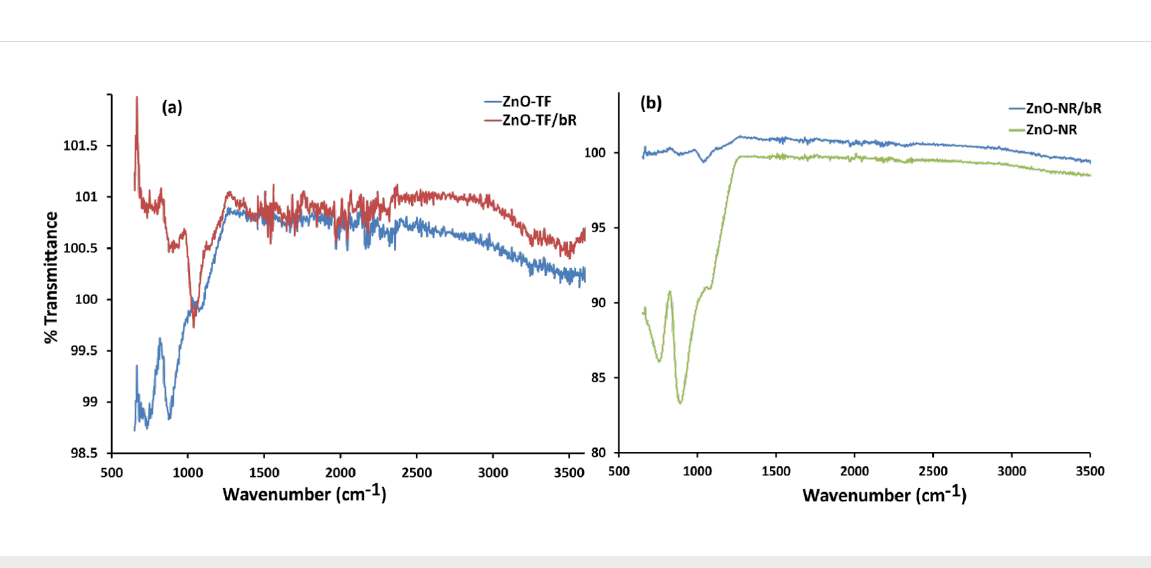
Figure 6: FTIR spectral analysis. (a) ZnO-TF and ZnO-NR/bR; (b) ZnO-NR and ZnO-NR/bR. The vibrational spectra of the ZnO-TF and ZnO-NR structures show the characteristic peaks of ZnO with a red shift ( ≈ 10 cm − 1 ) in the ZnO/NR structure, indicating the possibility of a confinement effect. The characteristic vibrational modes of bR were also observed in the hybrid structures with a small red